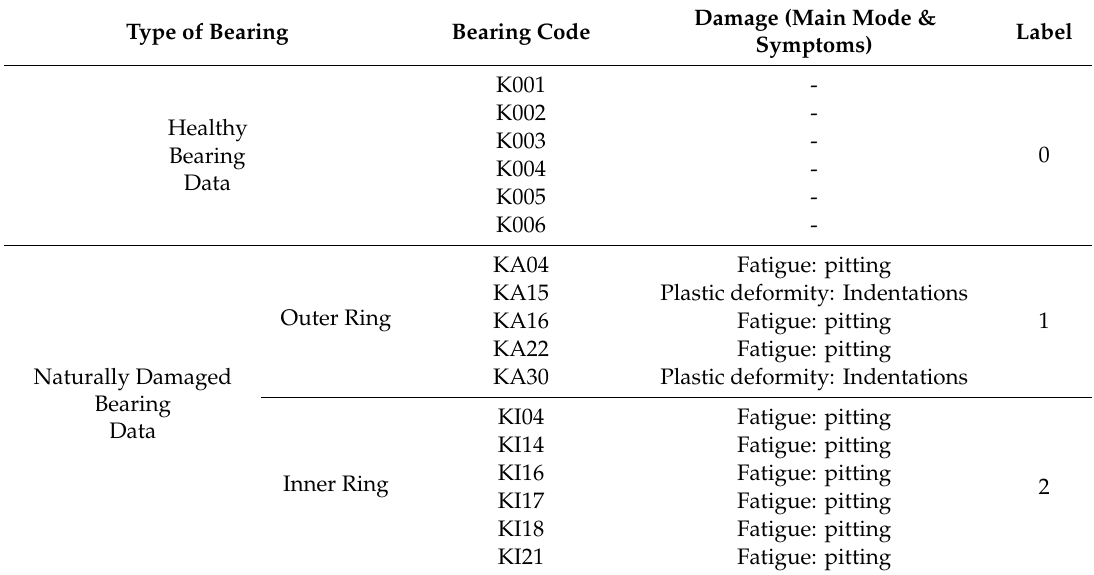
Table 2. Bearings considered in this work and their condition.